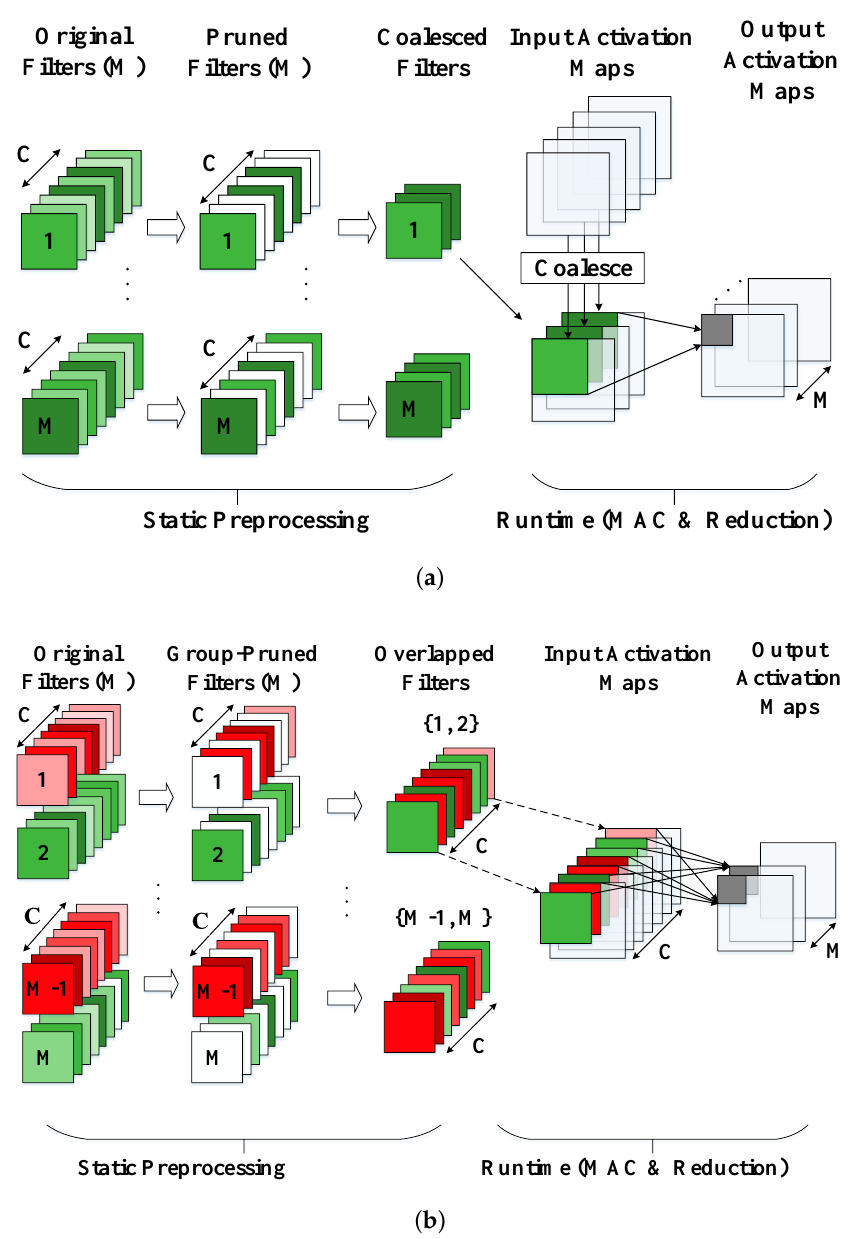
Figure 15. Sparse Convolution with ( a ) coalescing and ( b ) overlapping (adapted from